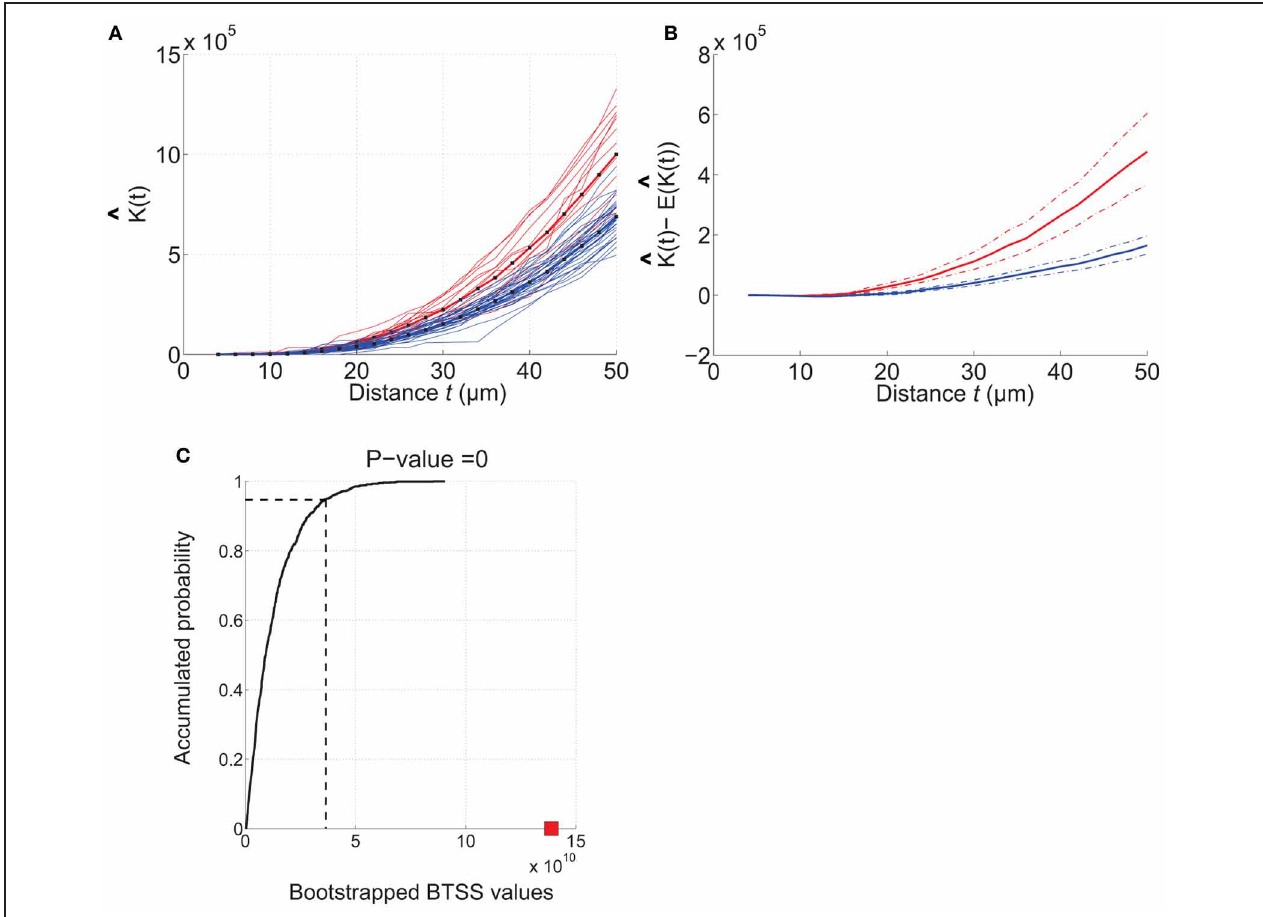
and barrel cortex. (C) The BTSS value for the experimental data (red square) is larger than the BTSS value at the 0.95 quantile of the accumulated probability distribution. The probability that the compared test distributions are from the same underlying distribution is thus less than 5%. These types of graphs can be generated with the RipleyGUI